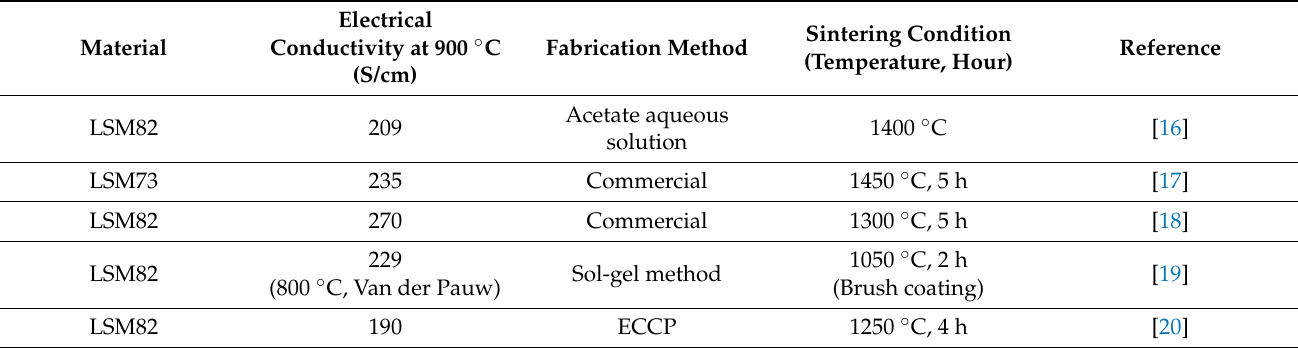
Figure 5. Arrhenius plot of measured electrical conductivity according to lead wire spacing: ( a ) LSM-F and ( b ) LSM-K. Table 2. Literature review on Electrical conductivity of LSM.